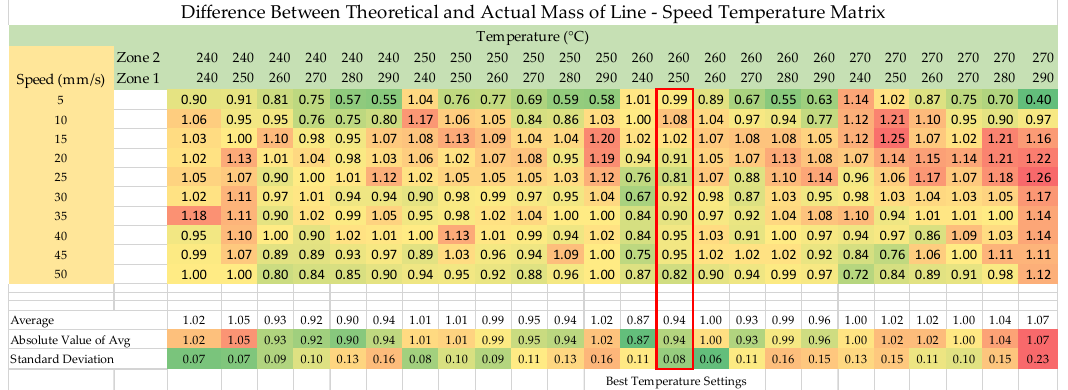
Figure 3. PC difference between the theoretical and actual mass of the line-speed temperature matrix.